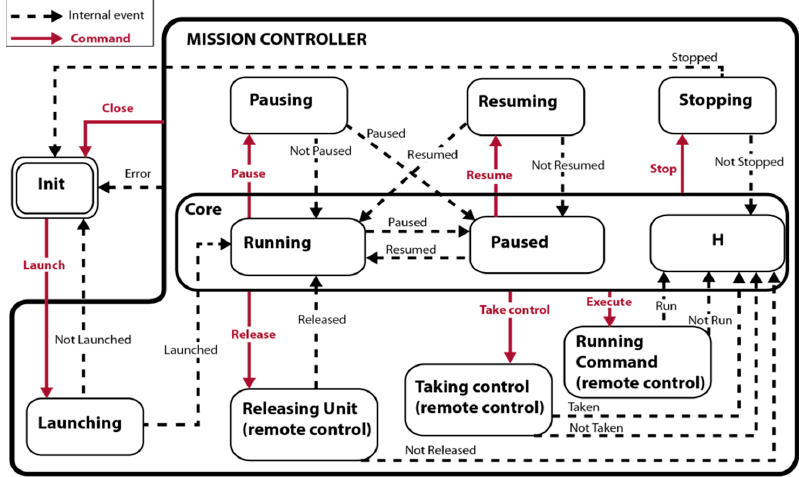
Figure 2. State diagram of a mission controller.